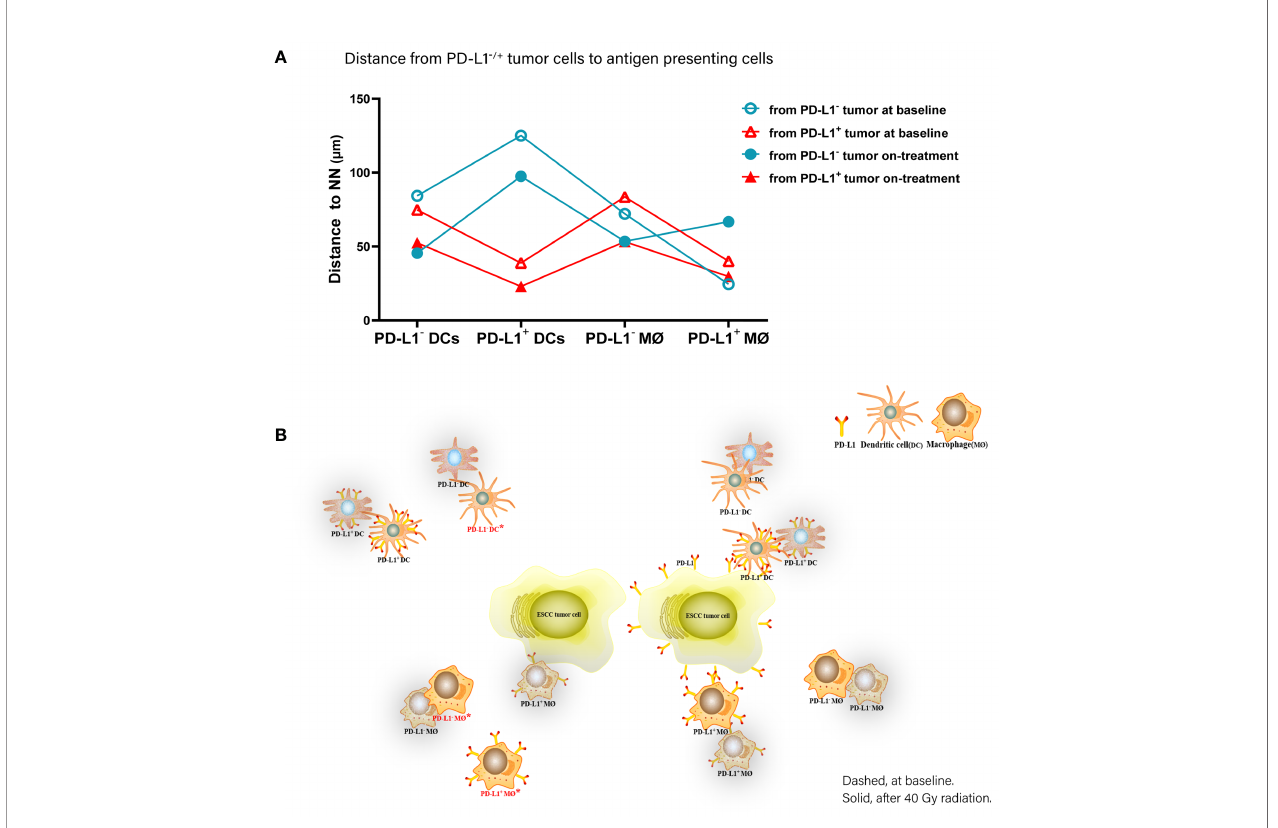
FIGURE 6 | Spatial distribution pattern dendritic cells and macrophages in ESCC patients under chemoradiotherapy combined with PD-1 blockade. (A) Dynamic alteration of distance from PD-L1 - or PD-L1 + tumor cells to the nearest PD-L1 - or PD-L1 + dendritic cells and macrophages in ESCC patients under combination treatment. (B) Model of dynamic spatial distribution of dendritic cells and macrophages in ESCC under treatment. Dashed, at baseline. Solid, after 40 Gy radiation. *, statistical signi fi cance of baseline distance from tumor cells to dendritic cells and macrophages compared with